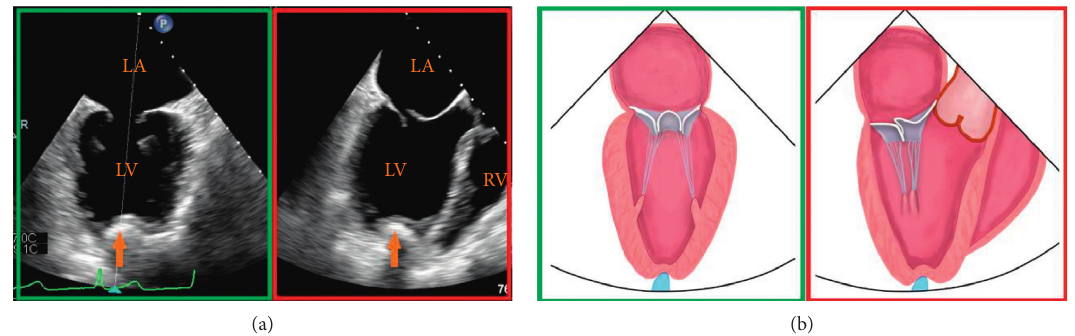
Figure 2: Determination of an appropriate transapical puncture site. (a) The notch of the fingertip (orange arrow) is displayed simul- taneously on X-plane views and schematic diagram (b), and oriented toward the center of the valve